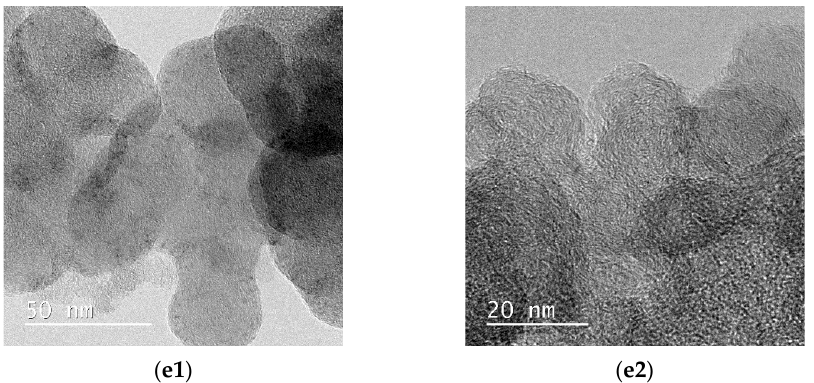
Figure 2. TEM images of the different electrocatalysts: ( a ) PdC; ( b ) PdCu1C; ( c ) PdCu2C; ( d ) PdCu3C; and ( e ) CuC (( a2 – e2 ) correspond with higher magnification micrographs compared to ( a1 – e1 )).